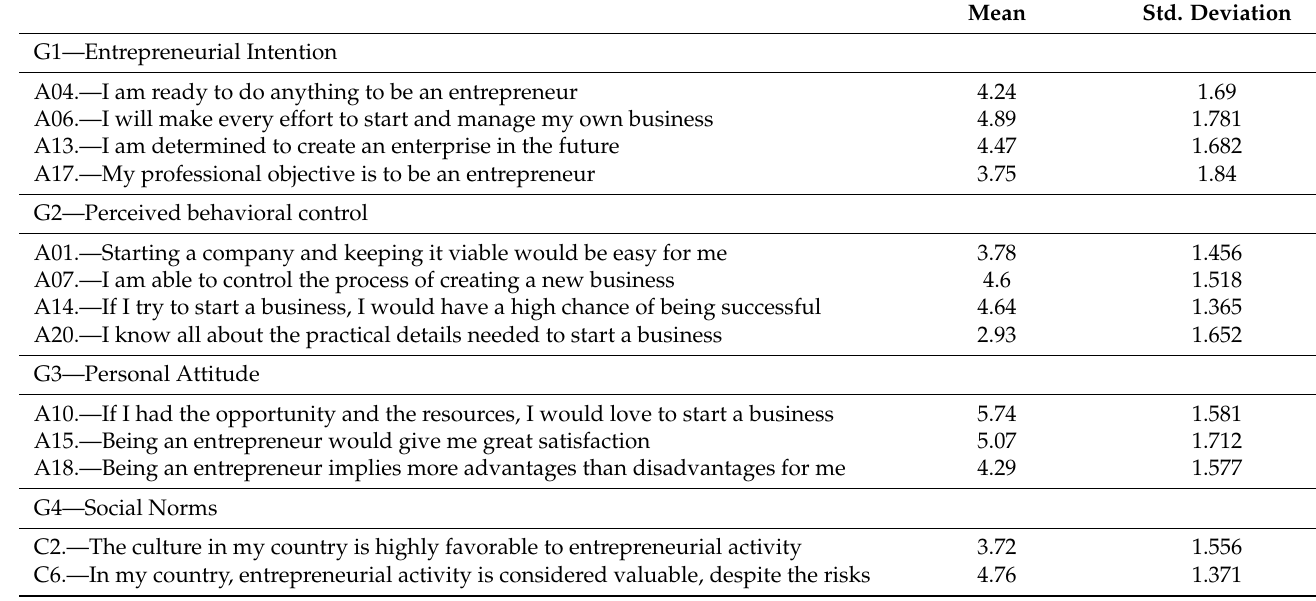
Table 2. Mean and standard deviation of questionnaire